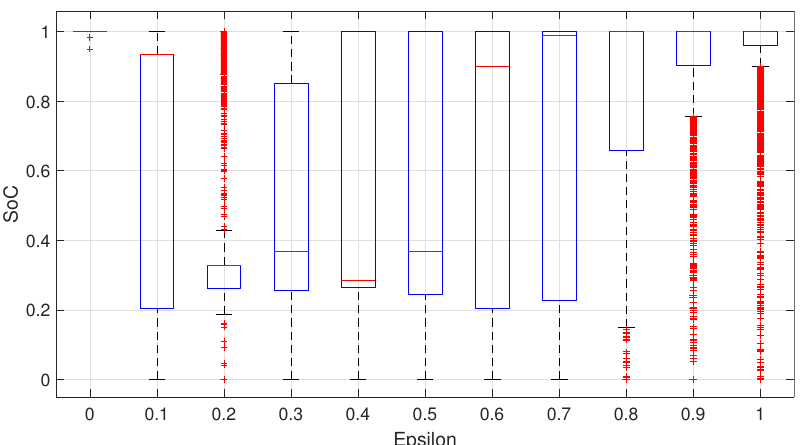
Figure 11. State of Charge (SoC) for different epsilon values.